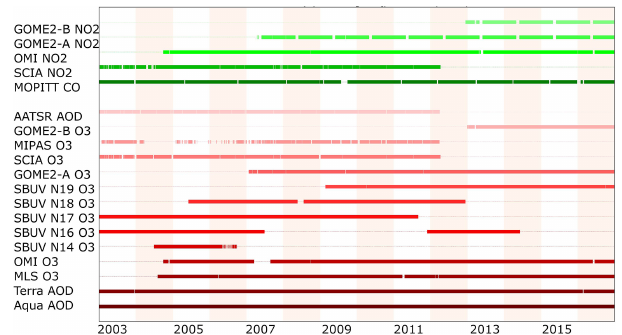
Figure 5. AC data assimilated in the CAMS reanalysis between 2003 and 2016. In red retrievals are shown for which no averag- ing kernels were used; in green those where averaging kernels were used are